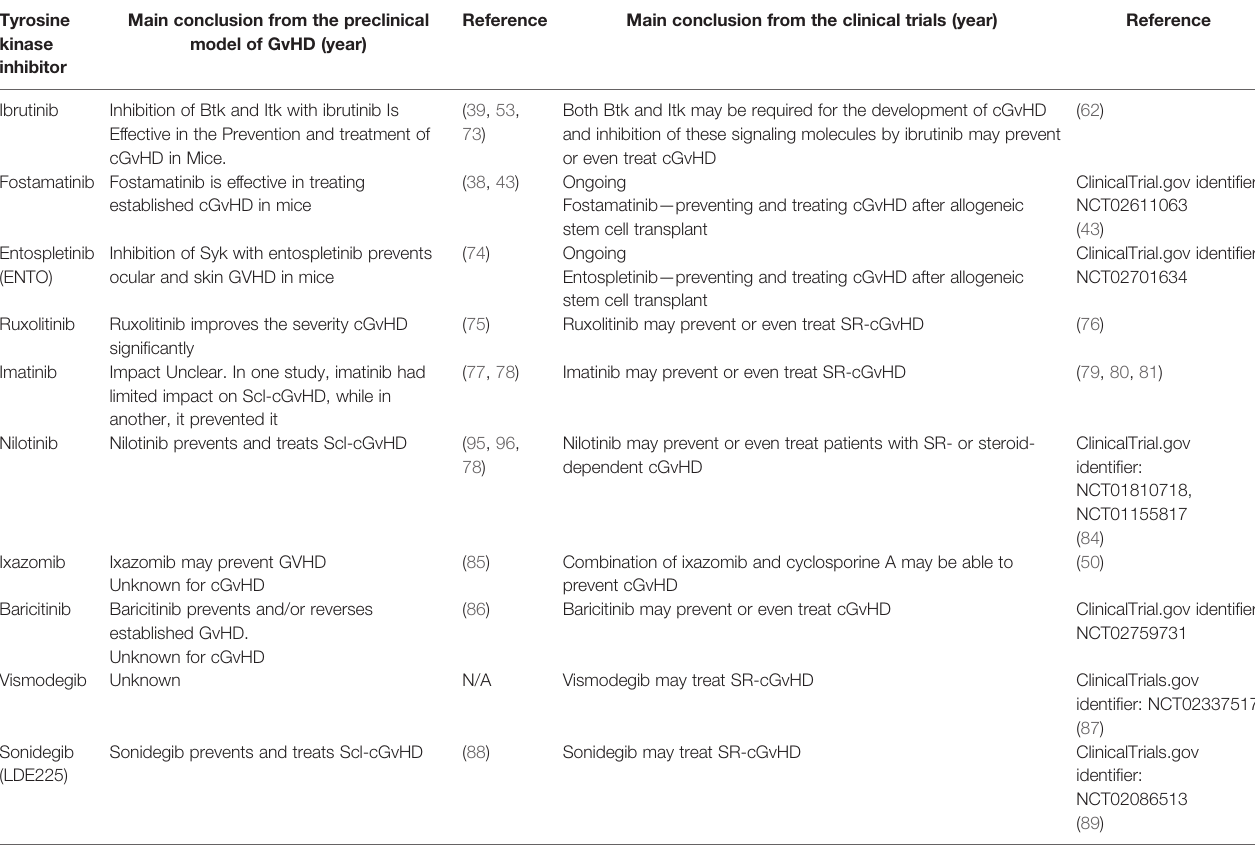
TABLE 3 | Translation of selected tyrosine kinase inhibition strategies from animal models of cGvHD into clinical trials. Tyrosine